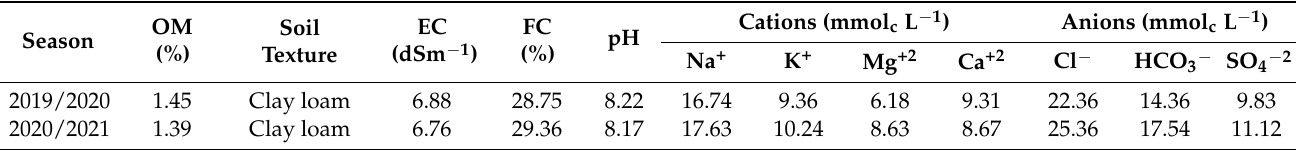
Table 1. Analysis of soil physiochemical properties during the 2019/2020 and 2020/2021 seasons.